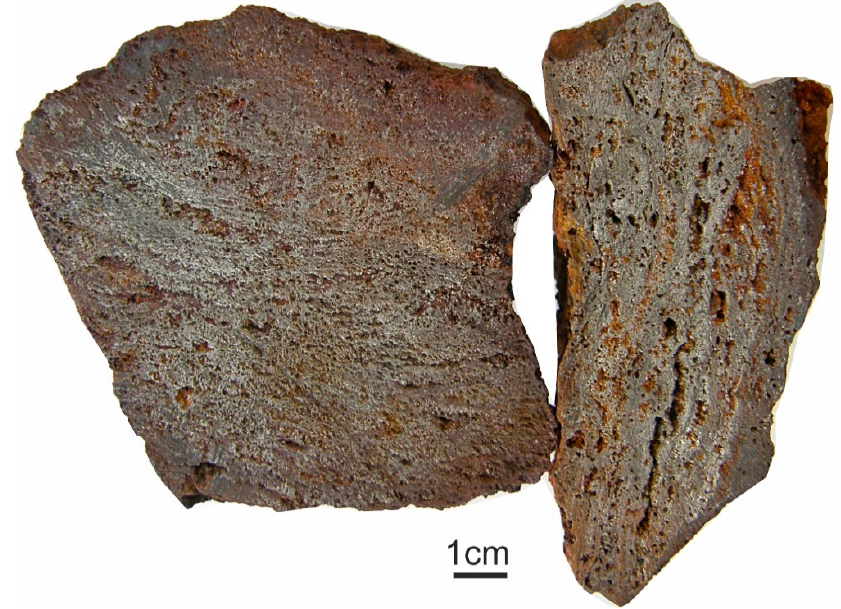
Figure 13. Massive porous sulfides from st. 372.